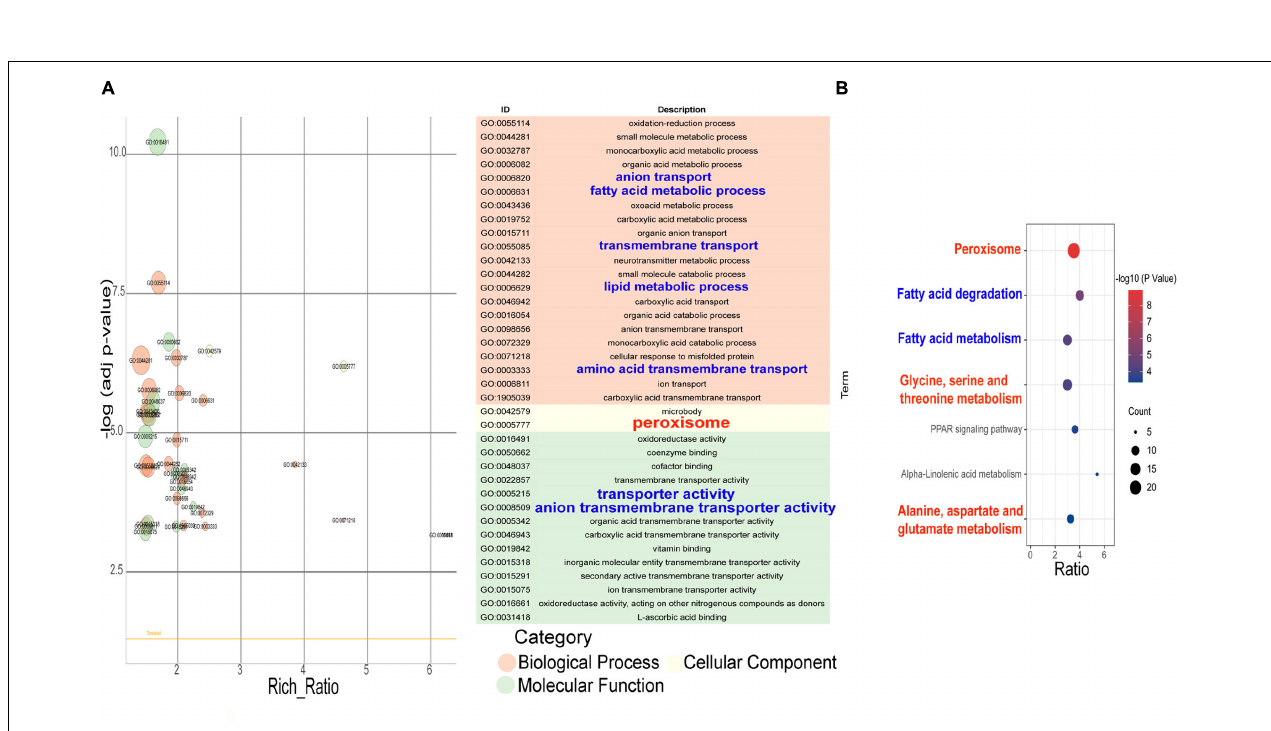
FIGURE 6 | GO enrichment item and KEGG enrichment pathway q value scatter plot of differentially expressed genes that the strains under the YM medium compares with the YPD medium. (A) GO enrichment item q value scatter plot. (B) KEGG enrichment pathway q value scatter plot.